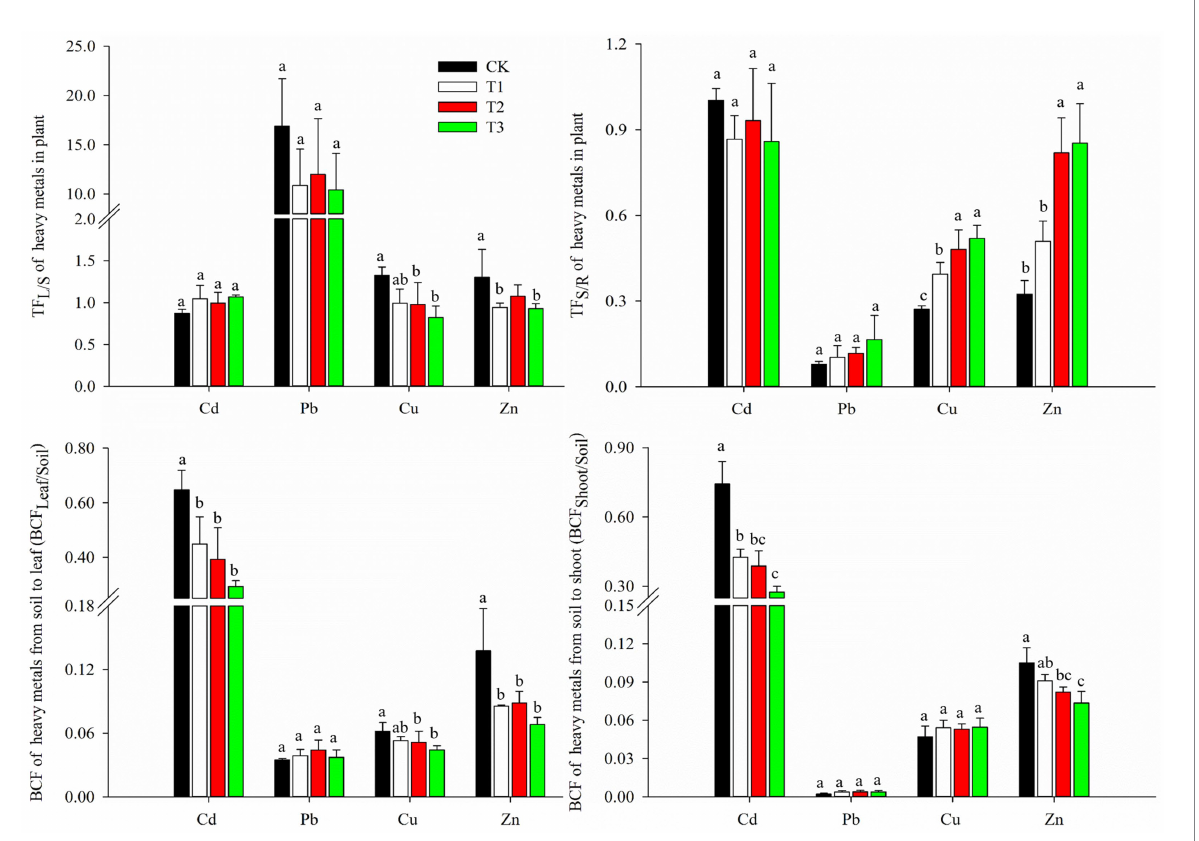
FIGURE 3 Effects of compost application on translocation factor and bioconcentration factor of heavy metals (mean ± SD, n = 3). TF L/S is the translocation factor of heavy metals from shoot to leaf, TF S/R is the translocation factor of heavy metals from root to shoot. BCF stands for the bioconcentration factor of heavy metals from soil to plant. CK, T1, T2, and T3 are compost application at rates of 0, 15, 30, and 45 t ha − 1 , respectively. The different lowercase letters indicate significant differences ( p < 0.05) between